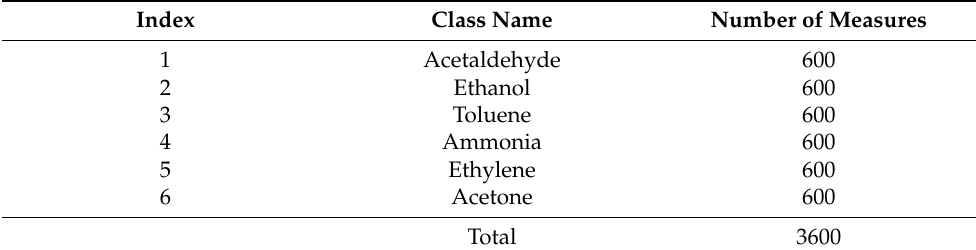
Figure 3. Initial arrangement of the collected data. Table 1. Number of measures in batch #10 of the EN dataset